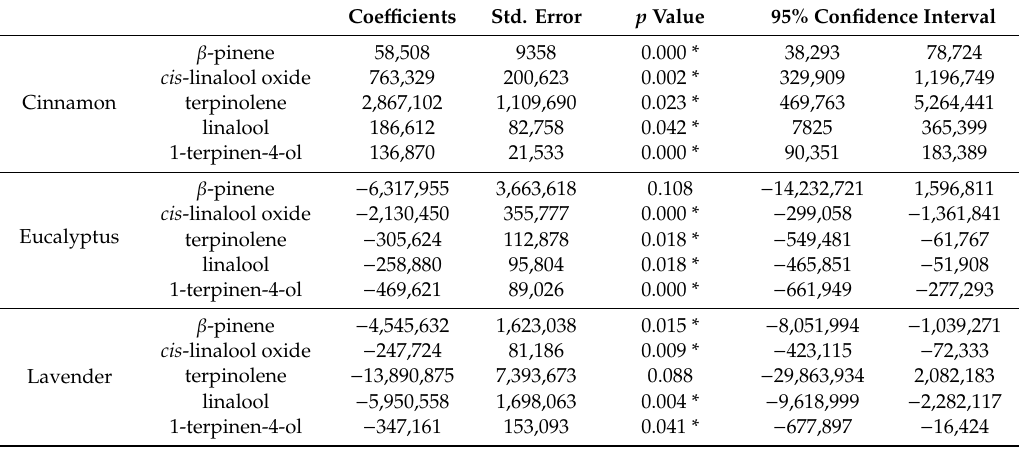
Table 2. Results of univariate GLM testing release rates for 5 consecutive